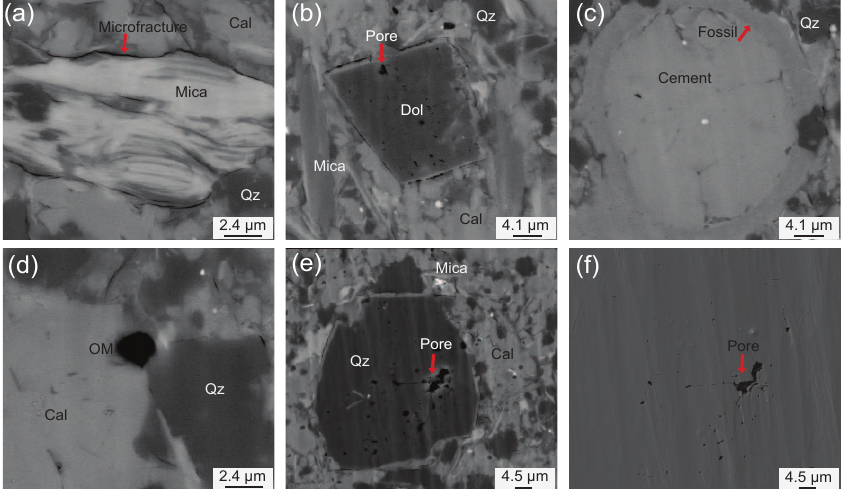
Figure 10. Images of BIB-SEM prepared sub-samples to show different pore morphologies. (a) Microfractures occur along grain boundaries of mica aggregates. (b) Dissolution pores around and in dolomite (dol) grain. (c) Porosity reduction by cement infill of fossils. (d) Solid-state organic matter (OM), not to be confused with pore space. (e) Intra-particle pores in quartz probably reflecting fluid inclusions. (f) Scanning electron (SE) image of quartz grain with pores in sample G. Qz: quartz; Cal: calcite.